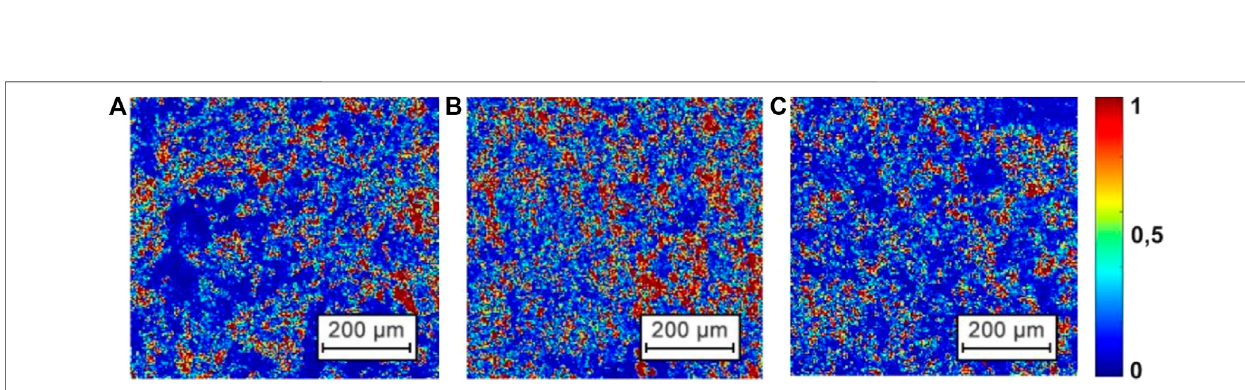
FIGURE 1 | Schematic presentation of the 3D Mueller matrix-based polarimetry system: 1 – HeNe laser; 2 – collimator; 3 – beam splitter; 4 – rotary mirror; 5,7,10,12,13 – polarisation fi lters; 6 – quarter wave plate; 8 – sample under investigation; 9 – strain-free objective; 14 – CCD camera; and 15 – PC.